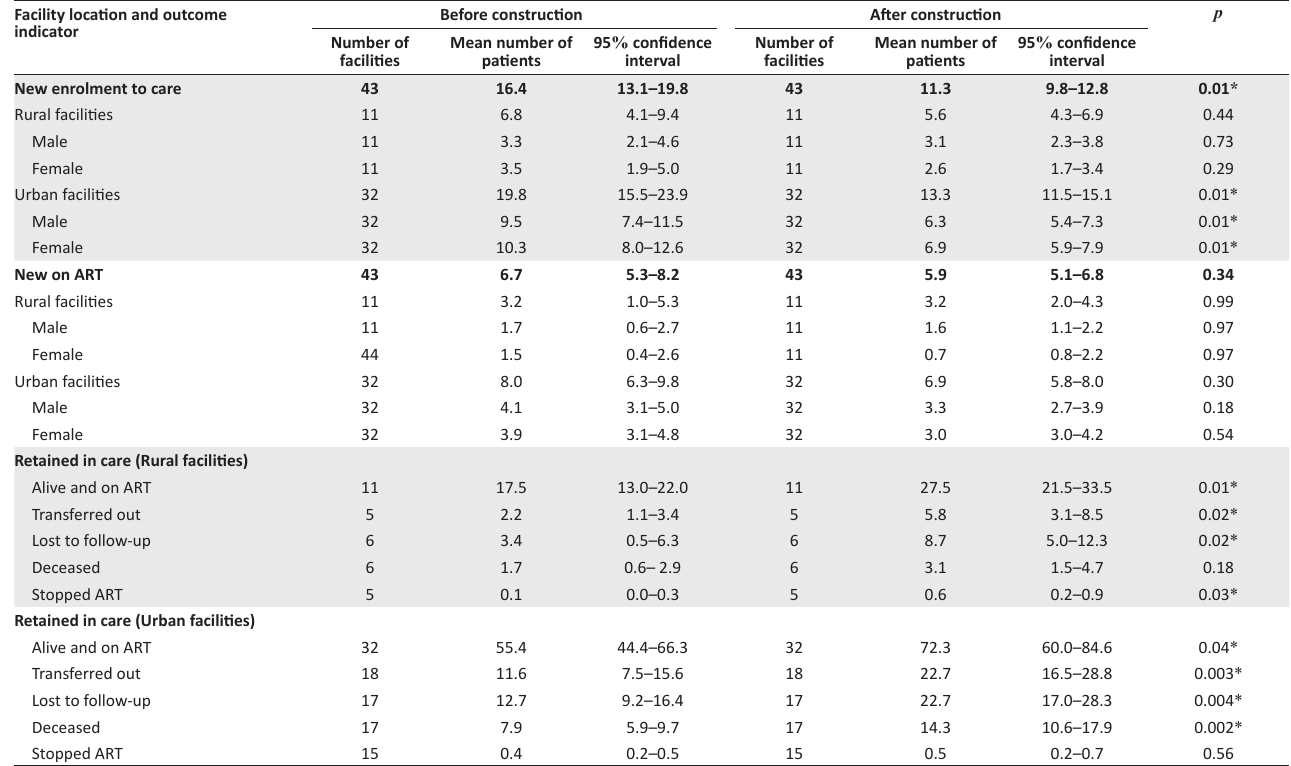
Facility location and outcome